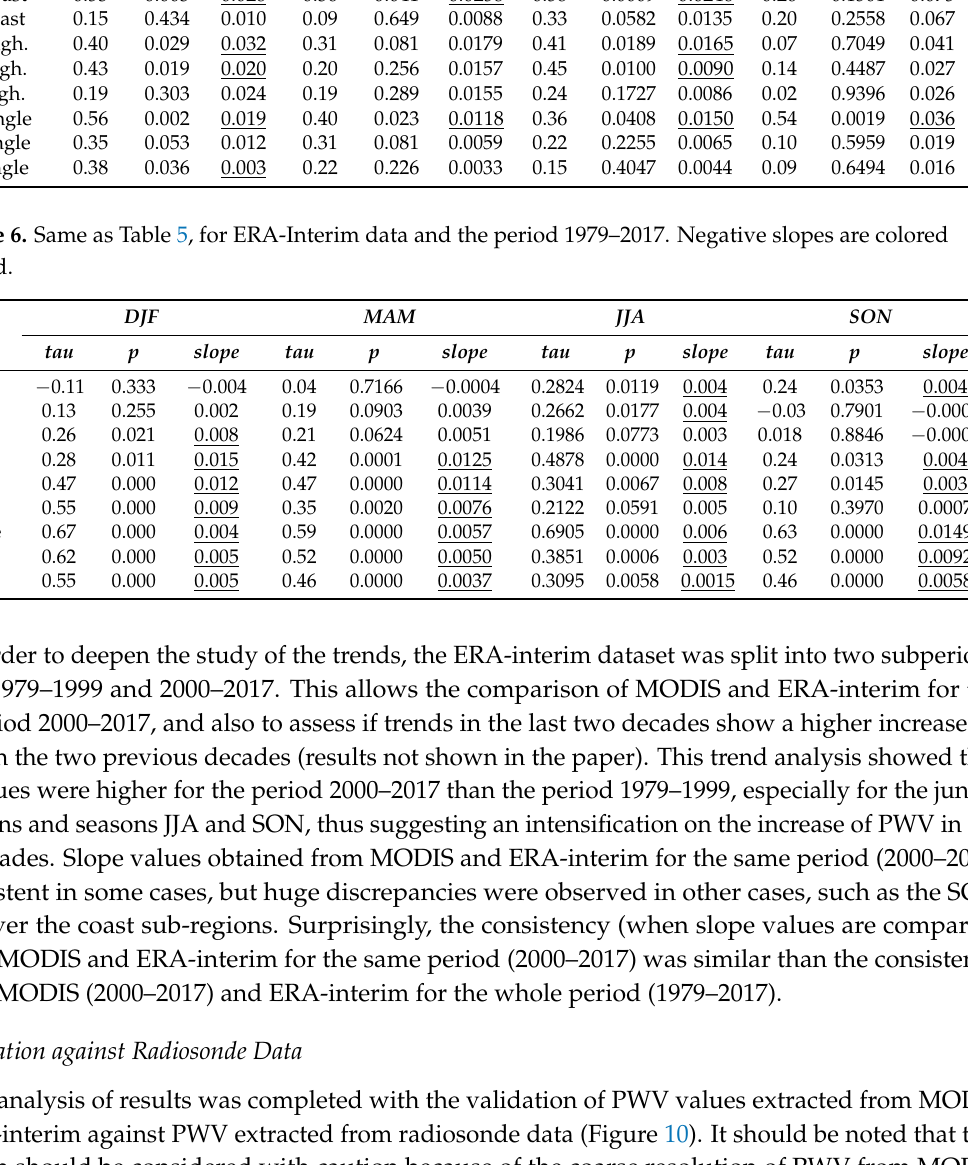
Table 5. Results of the Mann-Kendall test applied to seasonal (DJF, MAM, JJA and SON) MODIS PWV anomalies for the nine sub-regions during the period 2000–2017. Values of tau coefficient, significance level ( p ) and slope of the trend (cm/year) are also given. Values of slope statistically significant ( p < 0.05) are underlined.